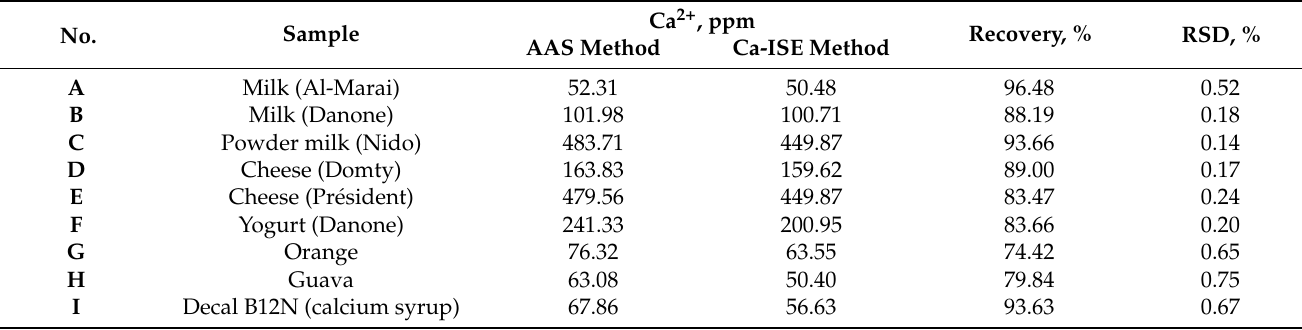
Table 6. Determination of calcium in samples by using the proposed